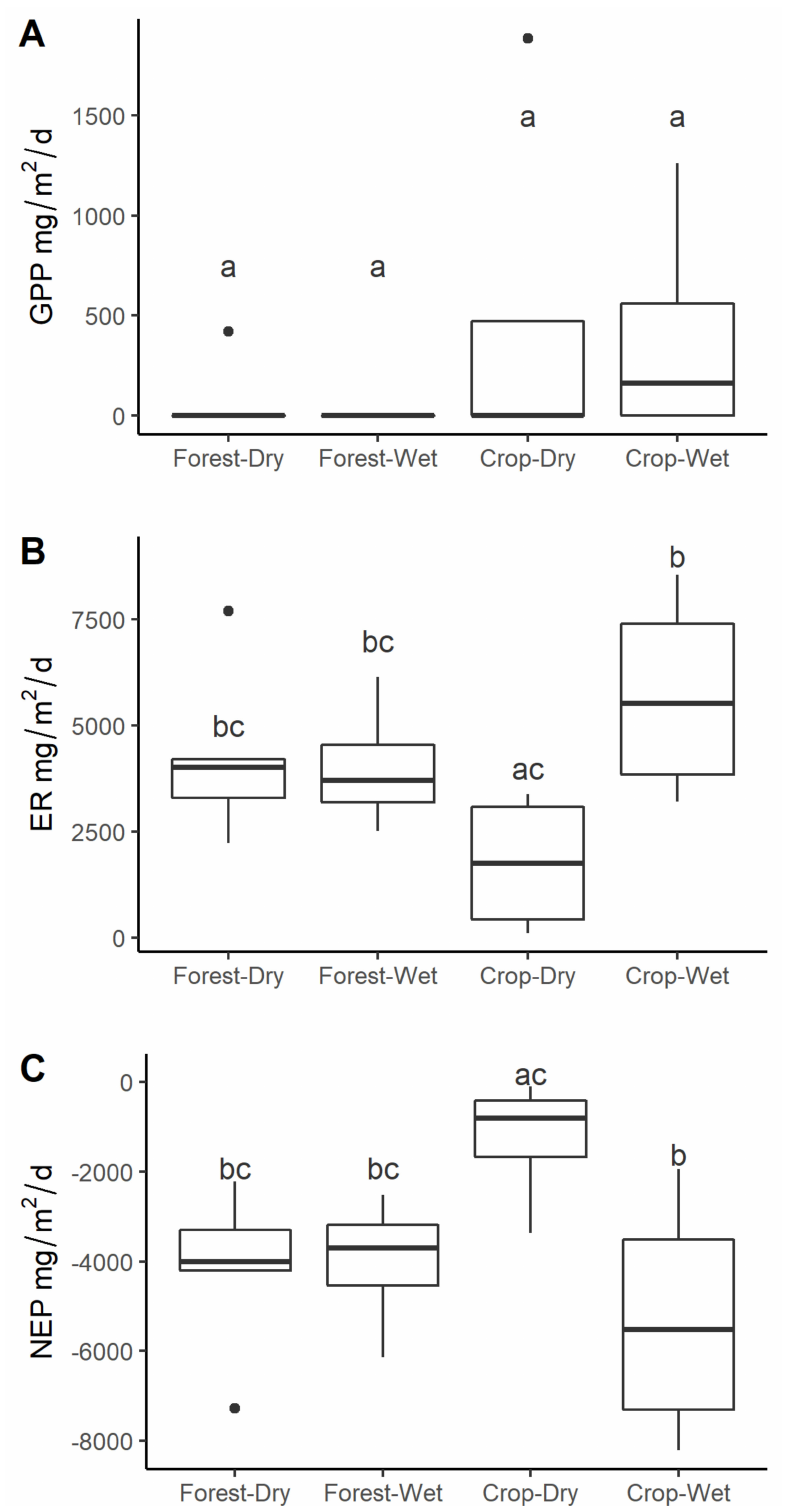
Figure 5. Median and variation in ( A ) gross primary productivity (GPP), ( B ) Ecosystem respiration (ER), and ( C ) Net ecosystem production (NEP) land use and season. Significant differences at p < 0.05 indicated by distinct letters above the boxes. Format of boxplots is as follows: horizontal line indicates the median value, box shows the inter-quartile range, and whiskers extend to 1.5 times the inter-quartile